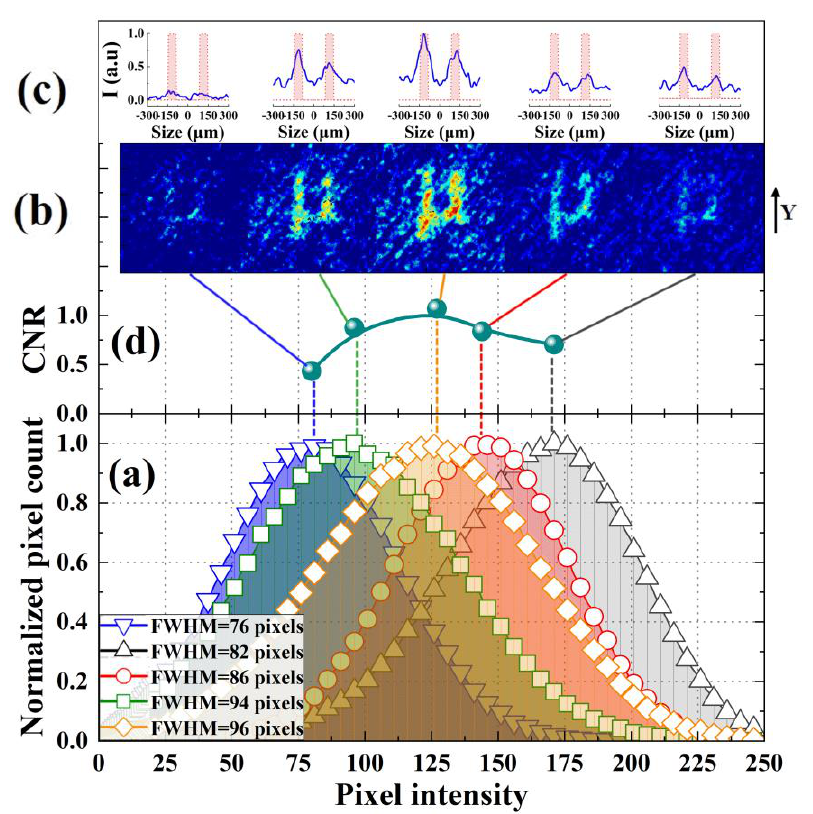
Figure 3. The evolution of the CNR and reconstruction of the object image. ( a ) The measured speckles’ pixel intensity distribution with different peak positions. Only one symbol is displayed for every 5 data. ( b ) The retrieved images of the letter “ µ ” in different FWHMs of the speckles’ pixel intensity distributions. ( c ) Solid blue lines are the horizontal line-outs of the normalized data of the retrieved ghost images and red dashed curves display the object. ( d ) The CNR as a function of different peak positions of the speckles’ pixel intensity distribution from the nonuniform pseudothermal light.